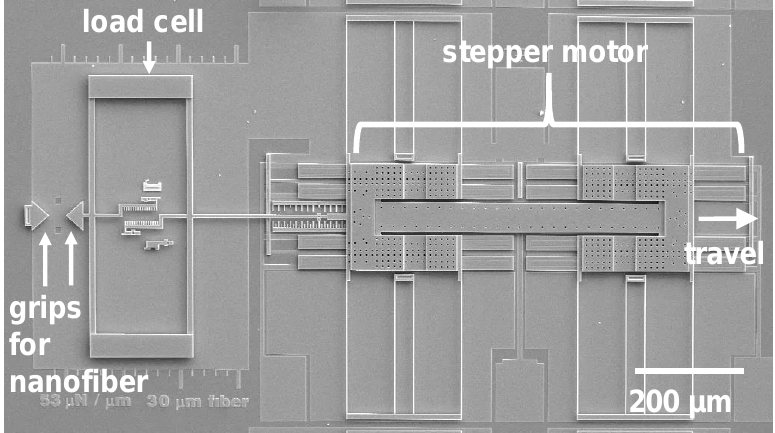
Figure 4. The micromachined test platform used for mechanical measurements.